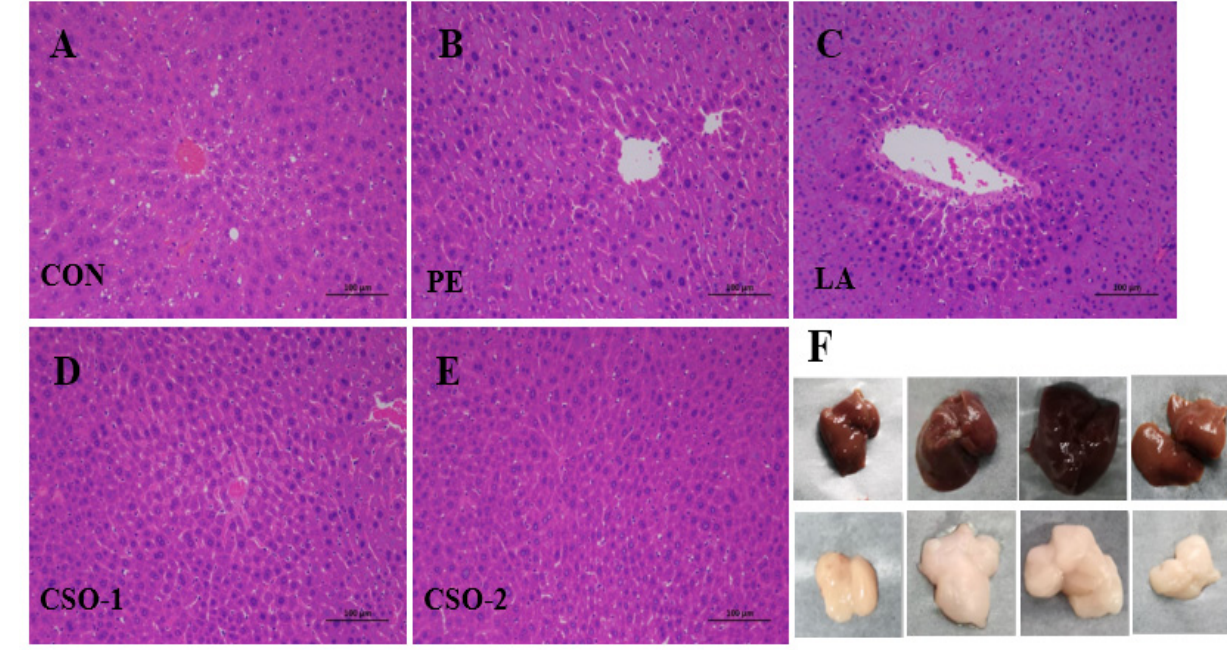
Figure 4. Morphological observation of mouse liver and epididymal fat. ( A – E ) Representative picture of pathological changes of liver tissues was observed by H&E staining (200-fold magnification); ( F ) Representative photos of mice livers and epididymal fat pads from control group, PE group, LA group and CSO groups (CON: given normal saline group; PE: peanut oil group; LA: lard group; CSO-1 and CSO-2: CSO oral injection groups of 30 mg/kg/BW and 50 mg/kg/BW, respectively).